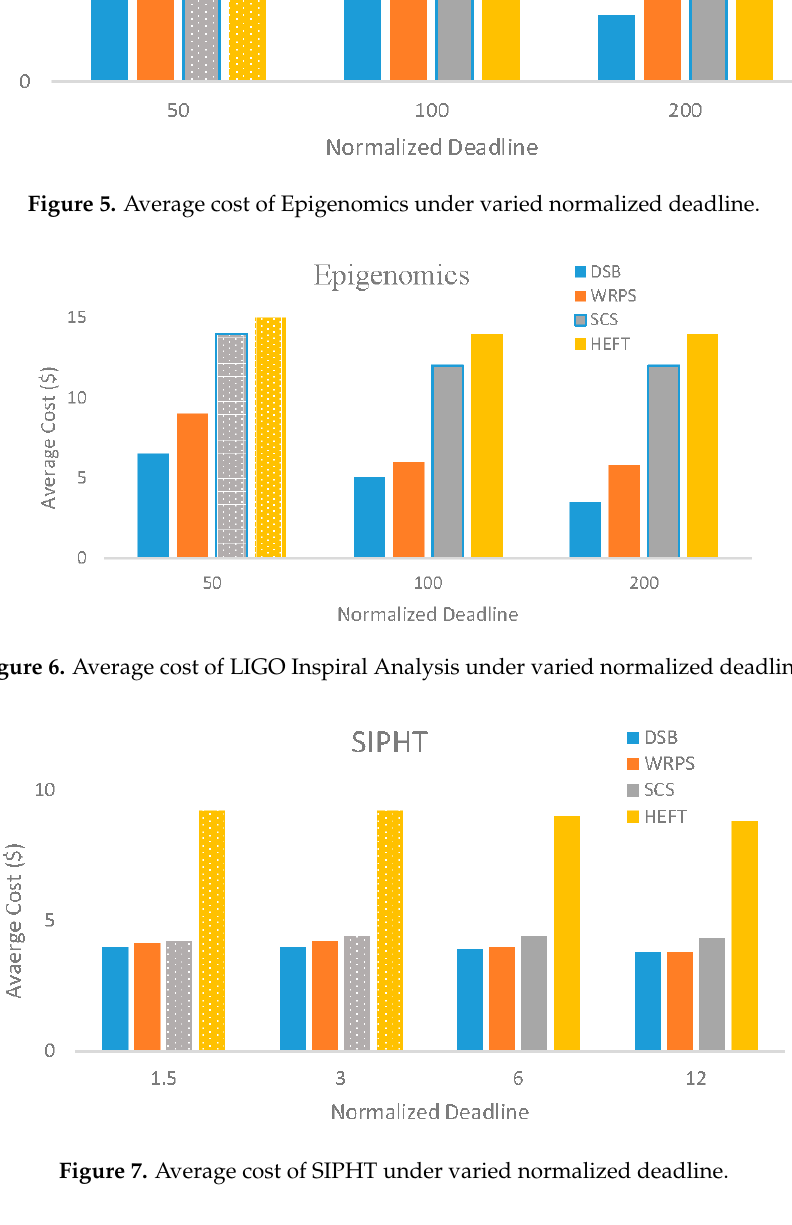
Figure 7. Average cost of SIPHT under varied normalized deadline.